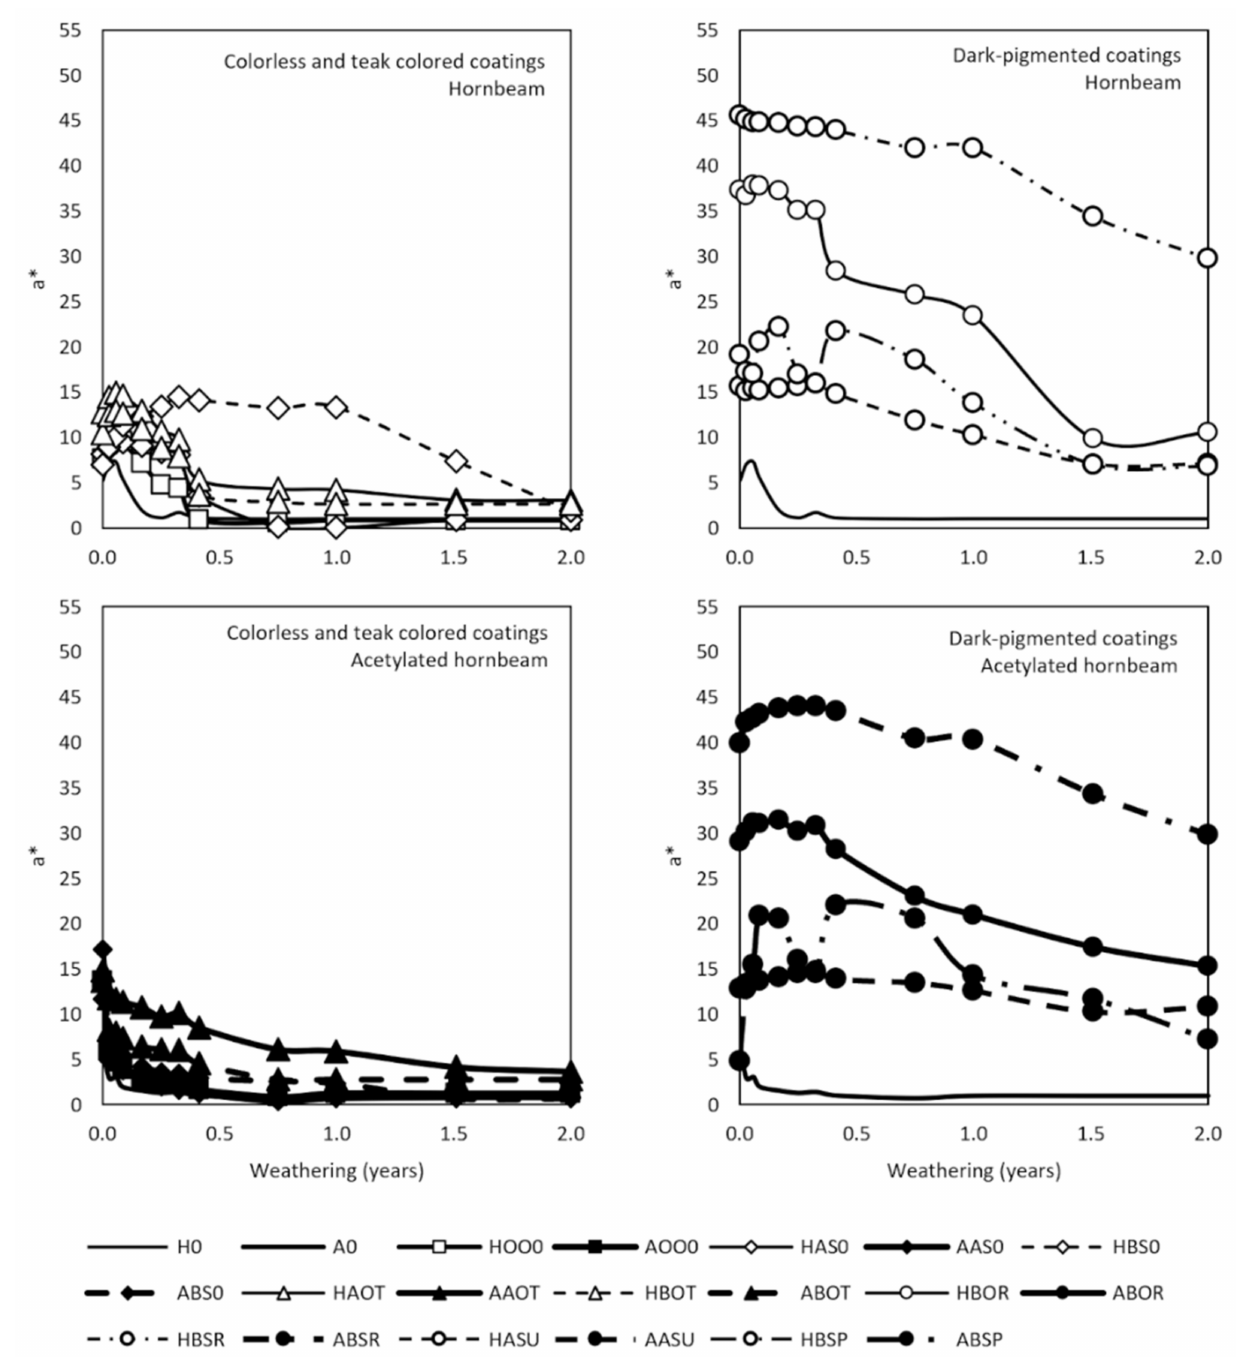
Figure 9. Change of red hue (a*) during two-year-long weather exposure. Initial increment was also the case of b*, but only for natural hornbeam samples and not for acetylated samples. Among colorless coatings, BS0 maintained the wood color for the longest period, but after the coating failed, the surface began to grey, resulting in an even larger color difference than that of the uncoated wood. The b* of every coating–except for BSP and BSR–decreased over time during weather exposure. AOT, BOT, and BOR experienced the biggest reductions. ASU, BSR, and BSP had the lowest ∆ b* (Figure